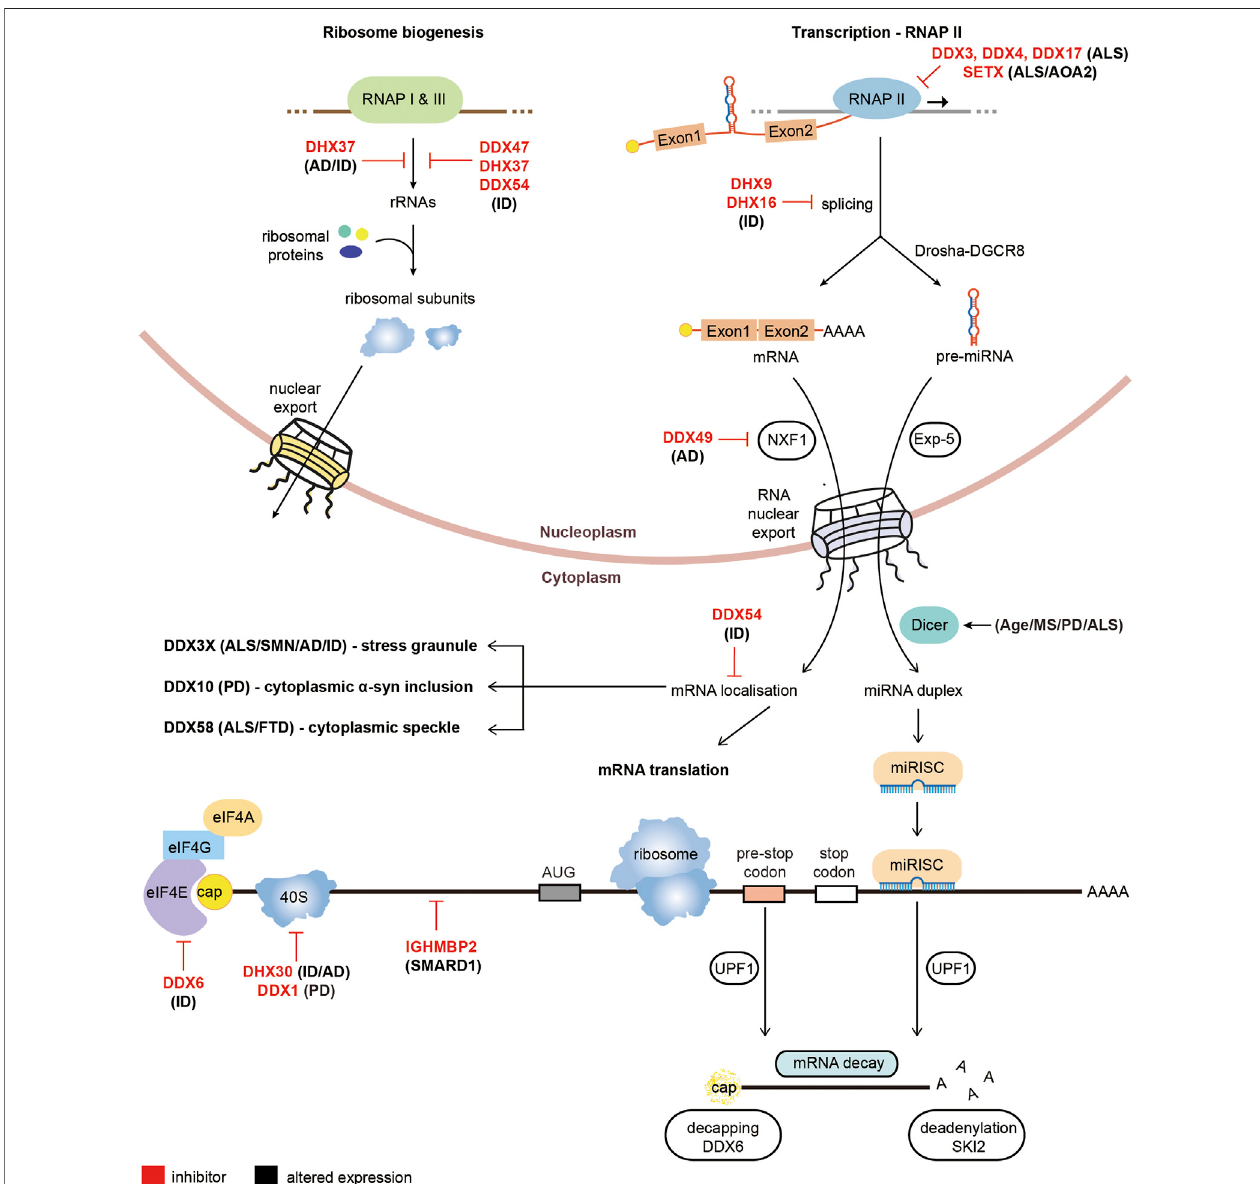
FIGURE3| PathologicalrolesofRNAhelicasesinnon-microsatelliterepeat-mediatedneurodegeneration.DiagramofRNAmetabolicfunctionswithRNAhelicases implicatedinnon-repeatneurodegenerativediseases. RNAhelicaseslabeledinredarepreventedfromperformingtheircellularfunctionswhileRNAhelicaseswithblack text have altered expression in neurodegenerative